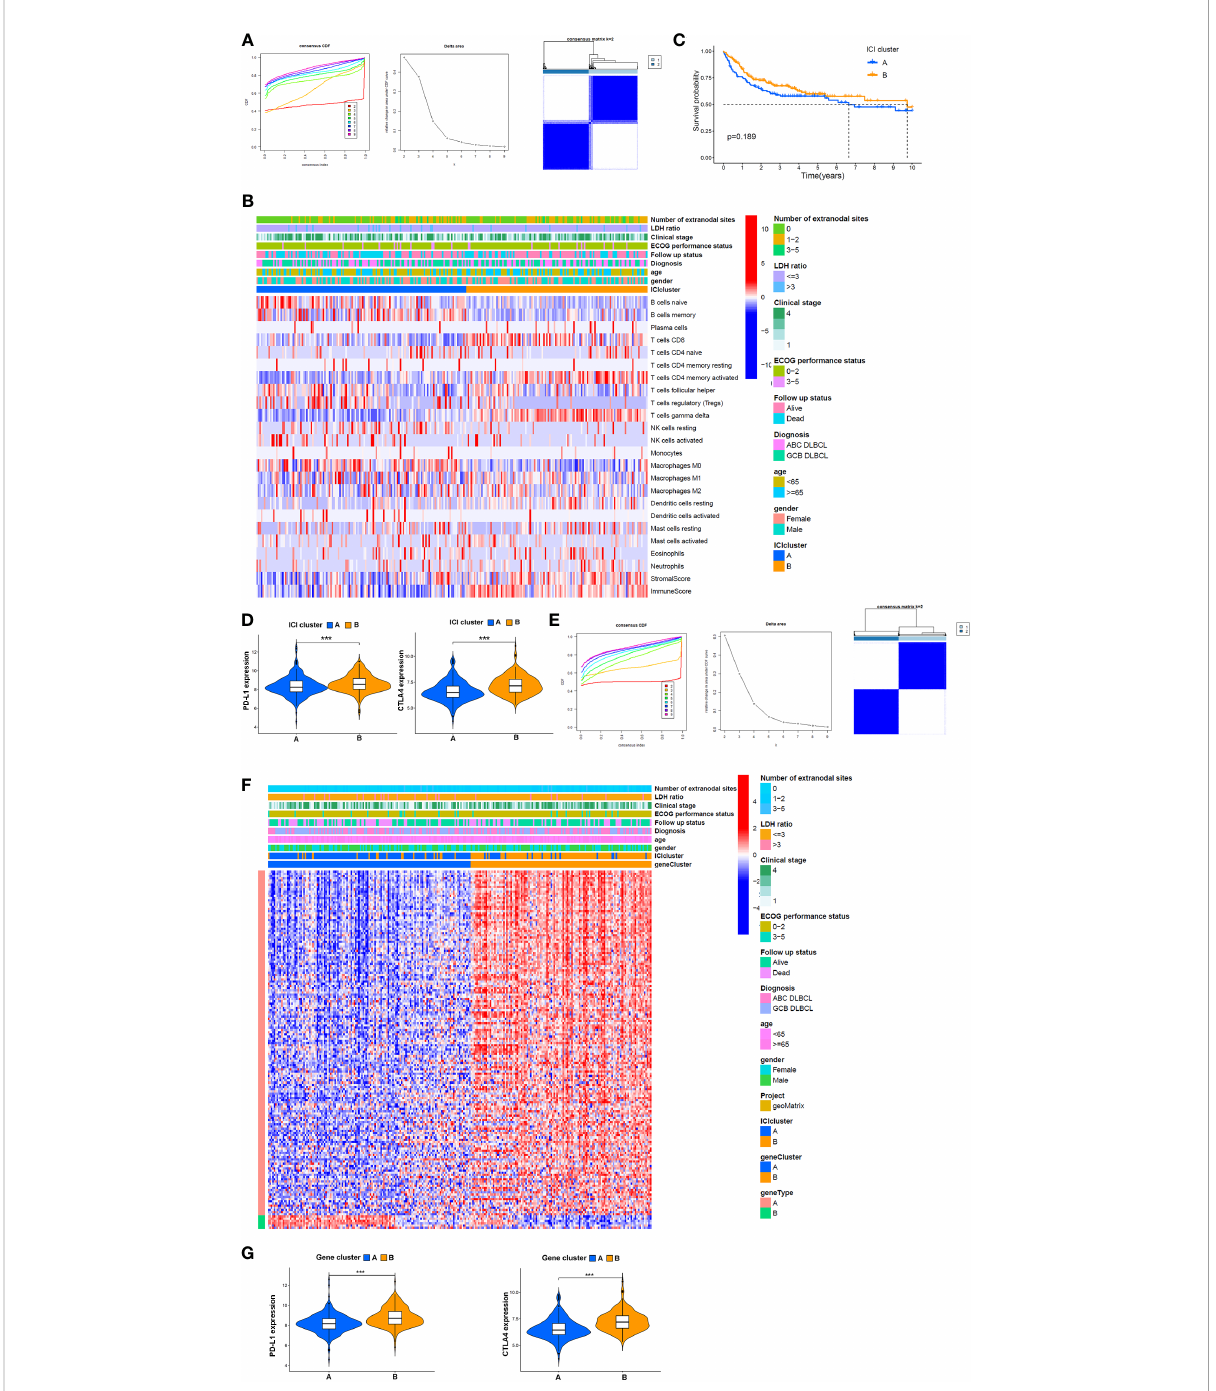
FIGURE 3 Potential association between TME components and clinical features. (A) Left: cumulative distribution function (CDF) of consensus clustering for k = ~2-9; middle: relative change in area under the CDF curve for k = ~2 – 9; right: relevance between the ICI A and ICI B clusters. (B) Heatmap and clinical features of two ICI subgroups de fi ned by 22 immune cell proportions. (C) OS analysis of different ICI subgroups via a Kaplan – Meier plot. (D) Expression of PD-L1 and CTLA4 in patients from distinct ICI subgroups. (E) Left: k = 2 – 9 for the CDF of the consensus clusters. Middle: the area variation under the CDF curve from k = 2 – 9. Right: association between gene clusters A and B, (F) Heatmap of association between the expression of DEGs in gene clusters, ICI subgroups, and clinical features. (G) Comparison of the expression of PD-L1 and CTLA4 between patients in different gene clusters.